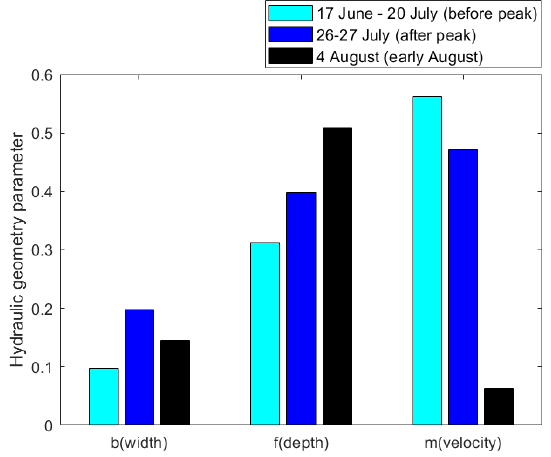
Figure 10. Hydraulic geometry parameters calculated for three dif- ferent times, (1) bulk of melt season before peak (melt episode in July) – 17 June–20 July, (2) after the peak (melt episode in July) but before an increase in peak timing – 26–27 July, and (3) after the peak (melt episode in July) and after an increase in peak timing (in early August) – 4